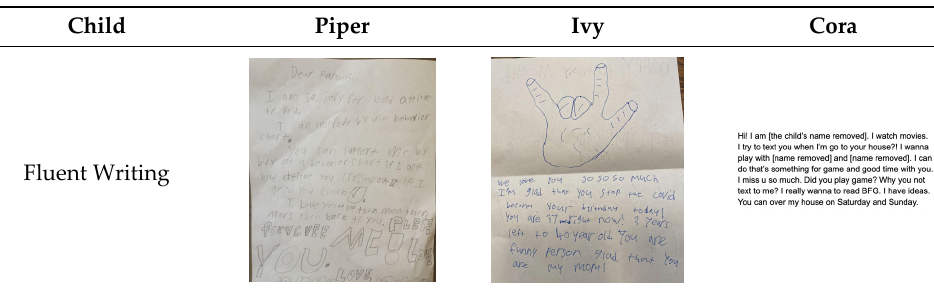
Table 5. Table 5. The Fluent Table 5. The Fluent Stage. Table 5. The Fluent Stage. Table 5. The Fluent Stage.